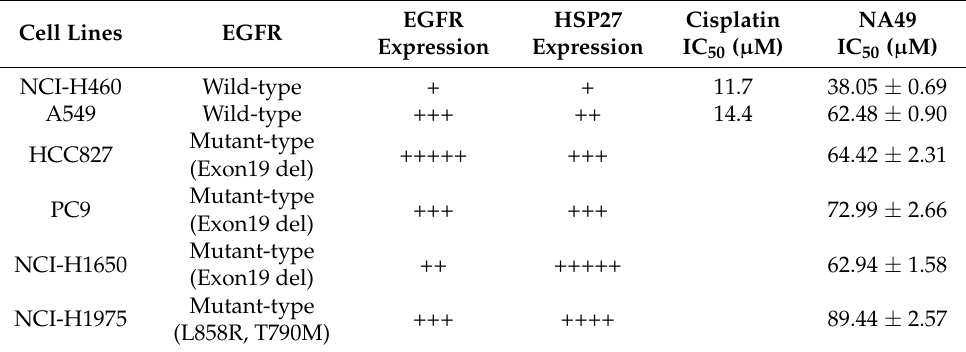
Table 6. Characterization of non-small cell lung cancer (NSCLC) cell